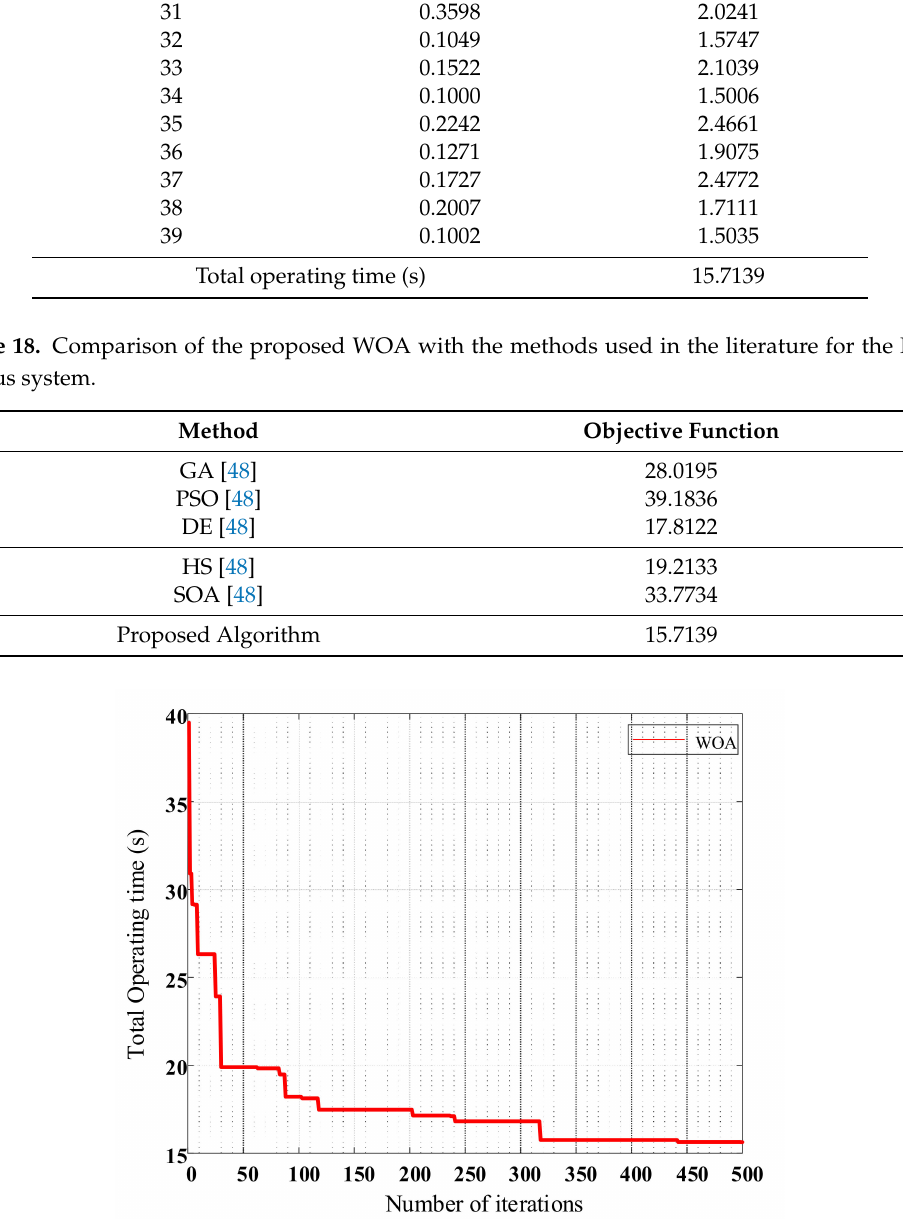
Figure 12. Convergence characteristic of WOA for Case